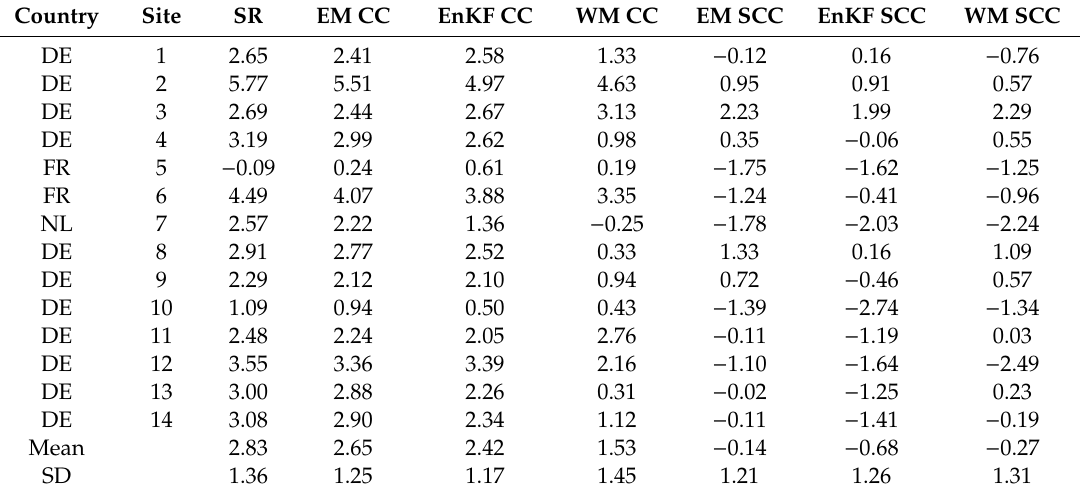
Table 8. Bias results for grain yields per site. SR: Standard Run, EnKF: Ensemble Kalman Filter, WM: Weighted Mean, EM: Ensemble Mean, CC: Crop Component Set, SCC: Soil and Crop Component Set. All values in t ha − 1 . Positive values indicate overestimation of the model, negative values indicate underestimation. DE: Germany, FR: France, NL: